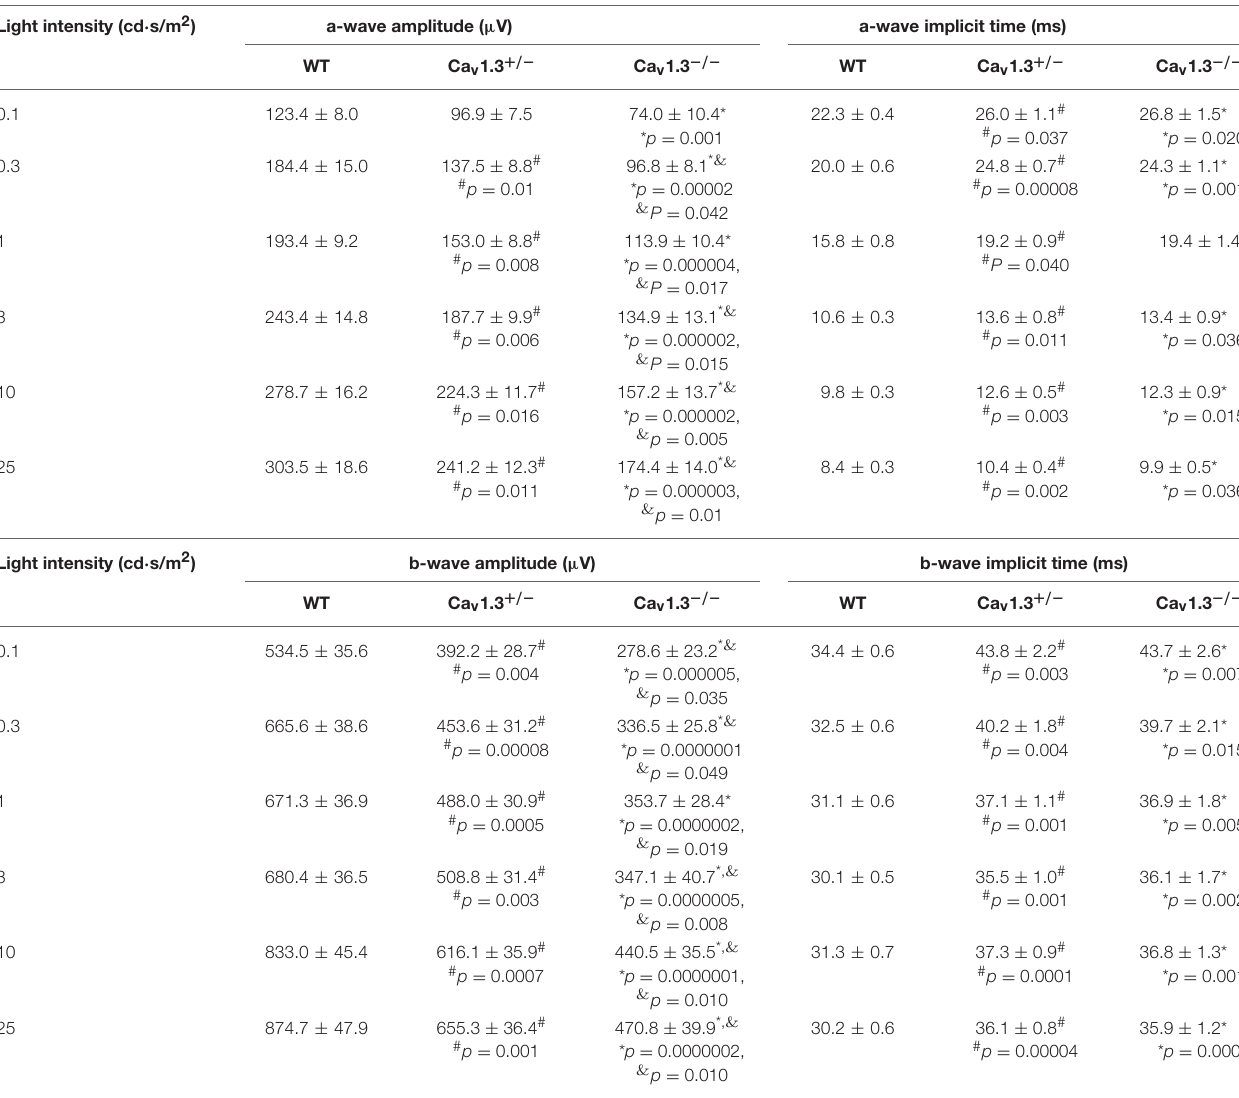
TABLE 1 | Dark-adapted retinal light responses (Data for Figures 4B–E ). Light intensity (cd · s/m 2